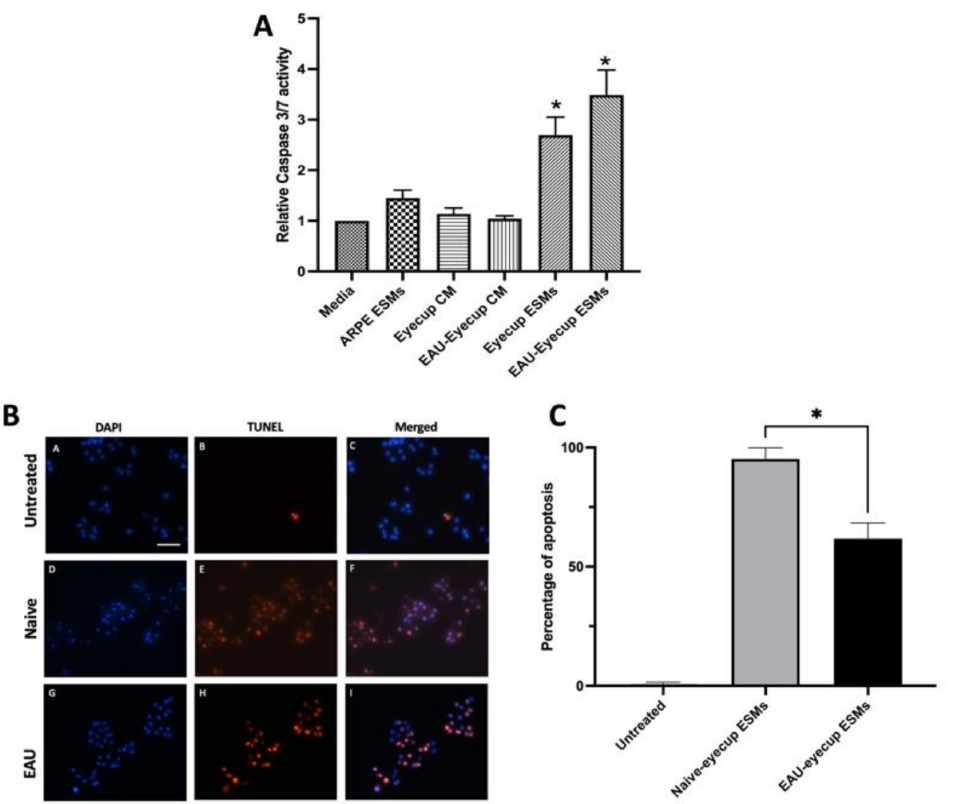
Figure 1. Induction of apoptosis in macrophages by RPE ESMs. The RAW264.7 macrophages were treated with whole conditioned media (CM) of naive or EAU eyecups (Eyecup CM or EAU-Eyecup CM), the ESMs from the conditioned media of naive or EAU eyecups (Eyecup ESMs or EAU-Eyecup ESMs), or the ESMs from confluent ARPE-19 cell cultures (ARPE ESMs) or were untreated (Media). ( A ) After 24 h, the cells were assayed for caspase 3/7 activity. Presented is the relative fluorescence (caspase 3/7 activity) to the background of untreated macrophages (Media) as mean ± SEM for 6 independent experiments for the EV-treated macrophages and 3 independent experiments for the conditioned-media-treated macrophages. Statistically significant (* p ≤ 0.001) levels of caspase 3/7 activity were seen only in the cultures of the macrophages treated with eyecup ESMs and EAU-eyecup ESMs in comparison with media alone. ( B ) Representative TUNEL-staining micrographs of RAW 264.7 macrophages treated with ESMs obtained from naive and EAU RPE eyecup for 24 h. Visual observations showed no TUNEL-positive cells in the untreated macrophage cultures (micrographs A–C), with most macrophages being TUNEL-positive after ESM treatment (micrographs D–I). Scale bar = 50 µ m. ( C ) The cells from the TUNEL assay were counted, and the percentage of TUNEL- positive cells over total DAPI-stained cells is presented as the mean ± SEM. The macrophages treated with naive ESMs had a significantly (* p ≤ 0.05) higher percentage of TUNEL-positive cells (95 ± 2%) than macrophages treated with EAU ESMs (62 ± 3%). The ESMs isolated from RPE eyecups (primary RPE cultures) induce apoptosis in the macrophage cell